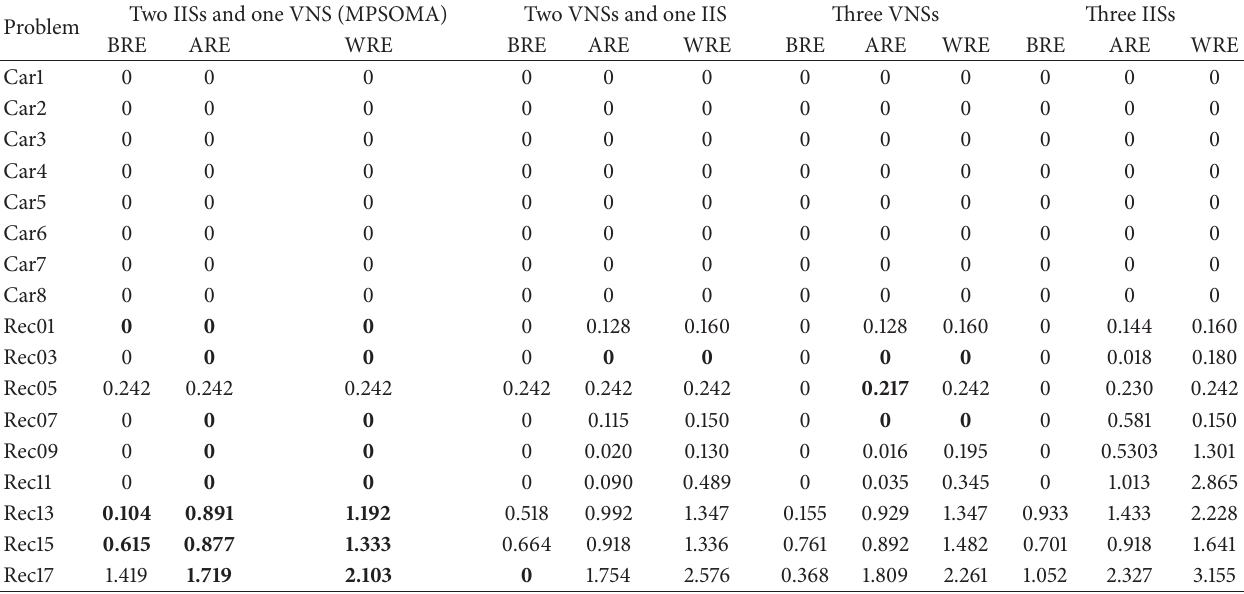
Table 6: Comparisons of usefulness of different local search